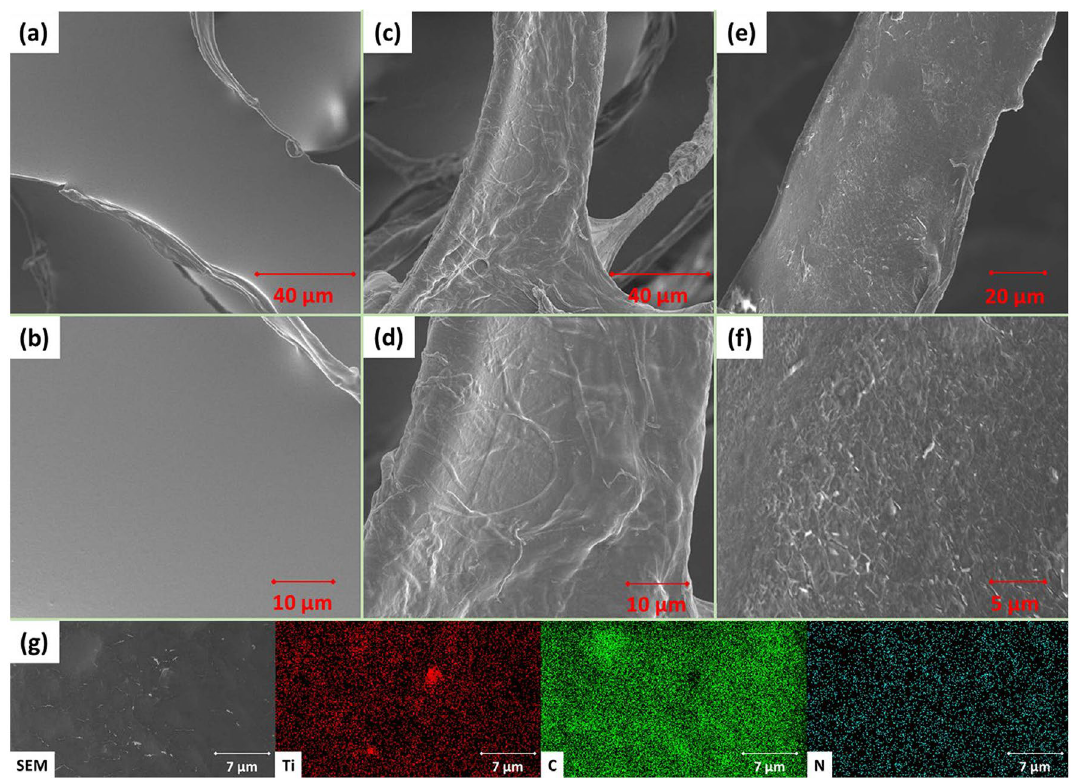
Figure 2. SEM images of ( a , b ) neat PUF, ( c , d ) [CH/PA] 1 coated PUF, and ( e , f ) [CH/PA/Ti 3 C 2 ] 1 coated PUF, and ( g ) EDS mapping image of [CH/PA/Ti 3 C 2 ] 1 coated